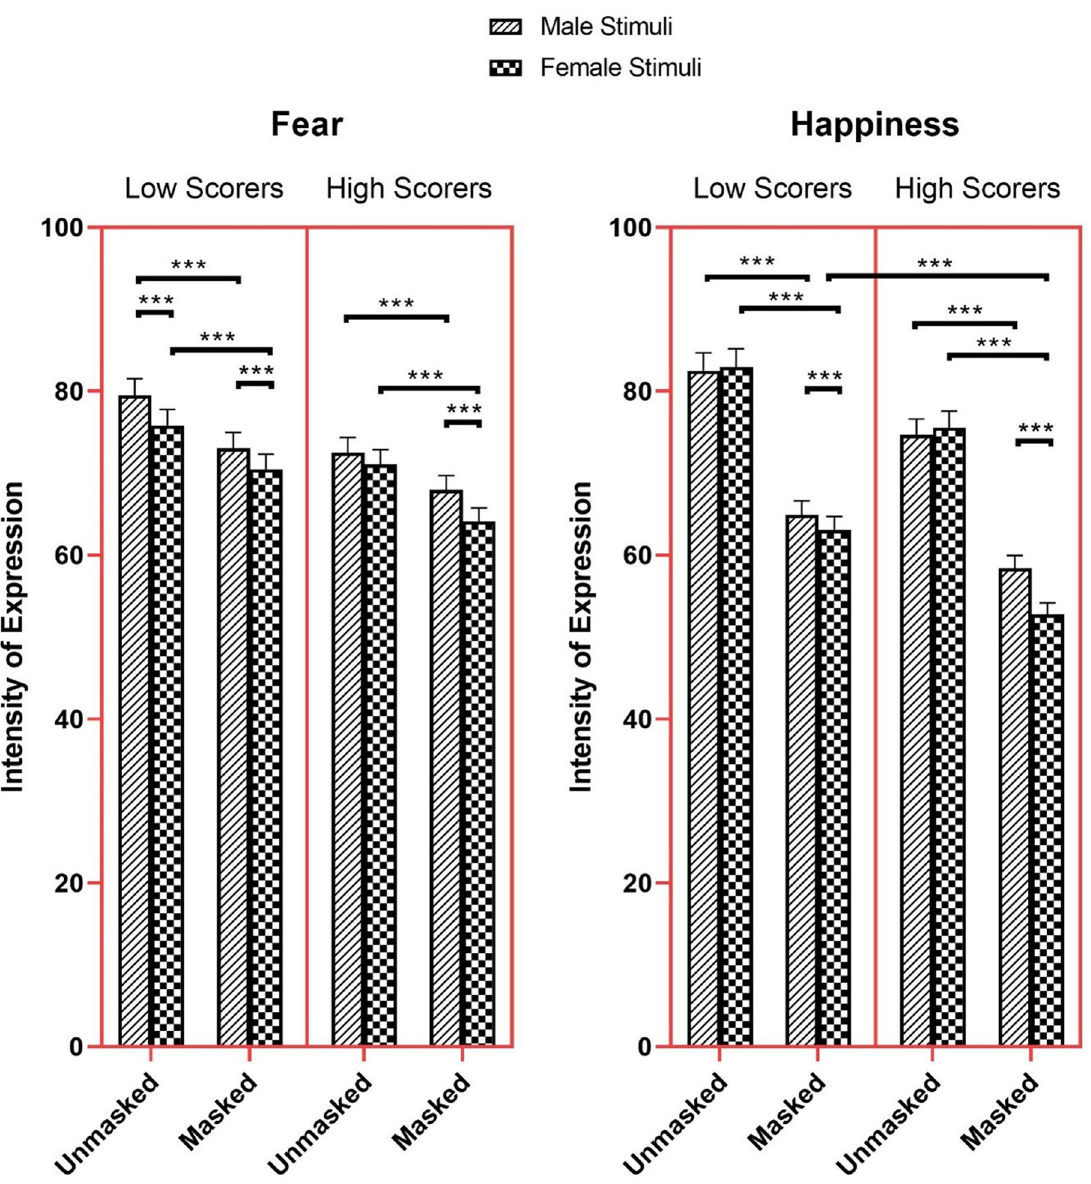
Fig 9. Intensity of expression ratings for fear and happiness as a function of mask, AQ-10 and stimuli sex. � p < 0.05, �� p < 0.01, ��� p <